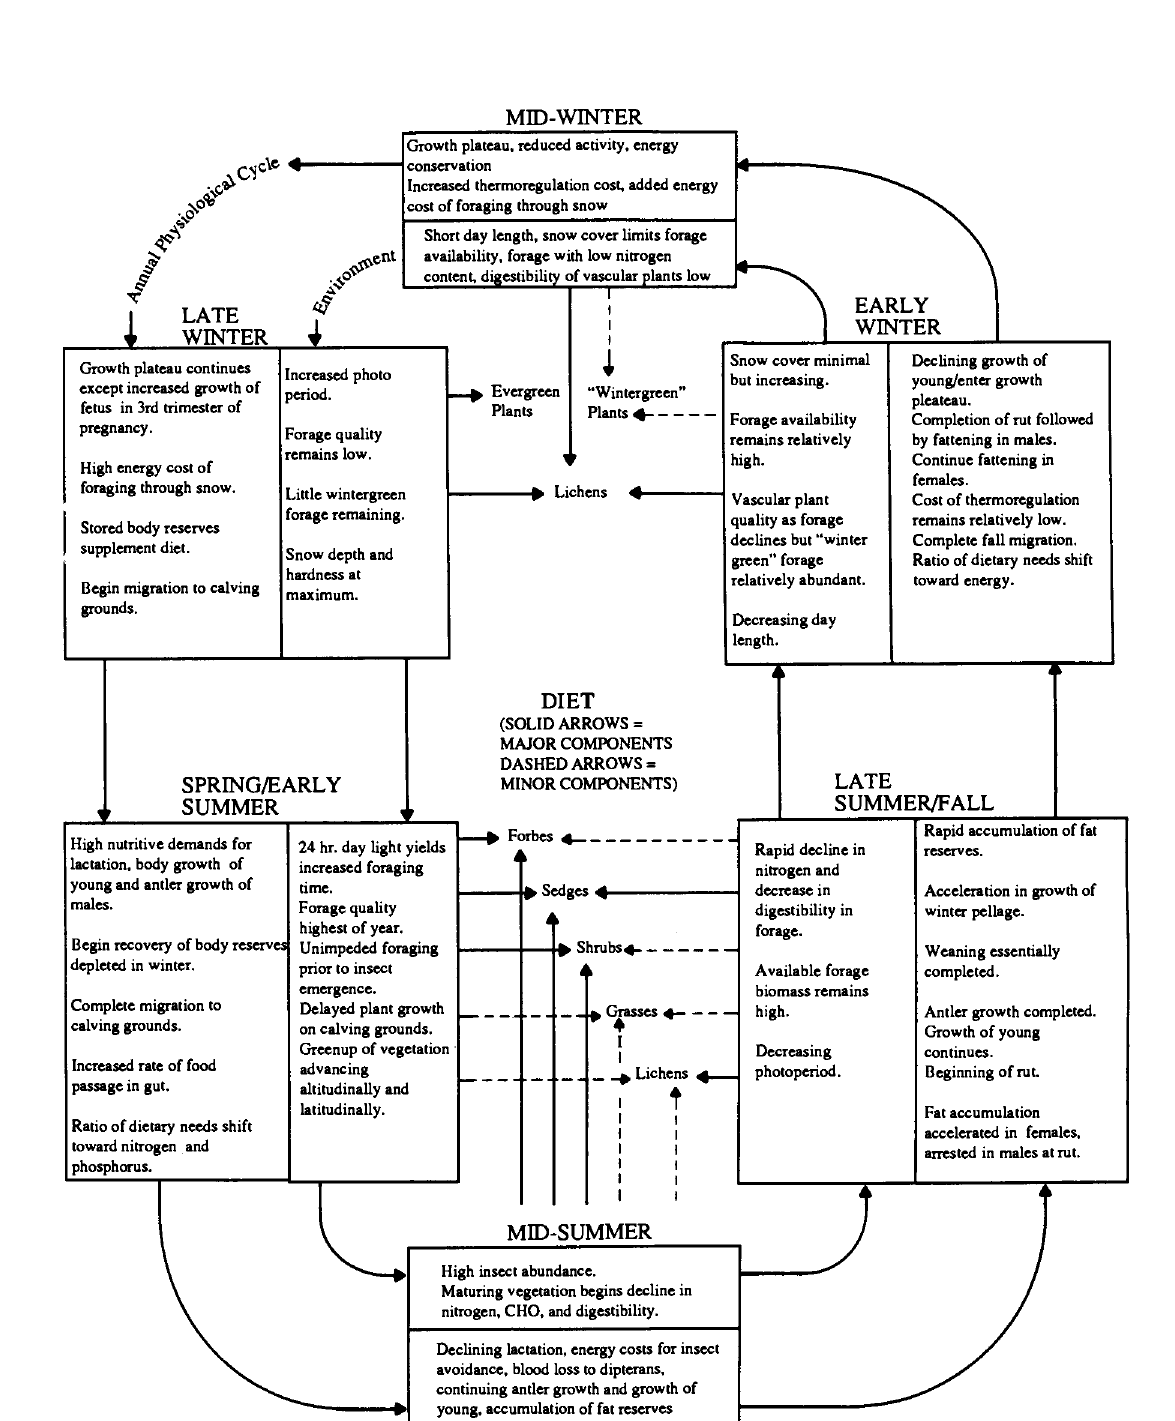
Fig. 2. Hypothetical model of the relationship of diet in caribou and reindeer to their annual physiological cycle and seasonal changes in the environment.